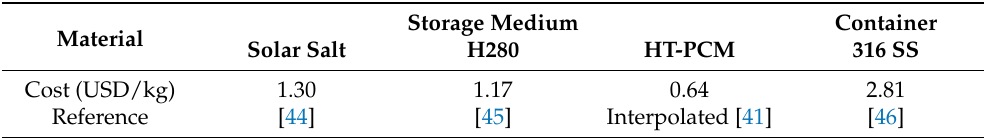
Table 4. Unit costs of different materials considered for